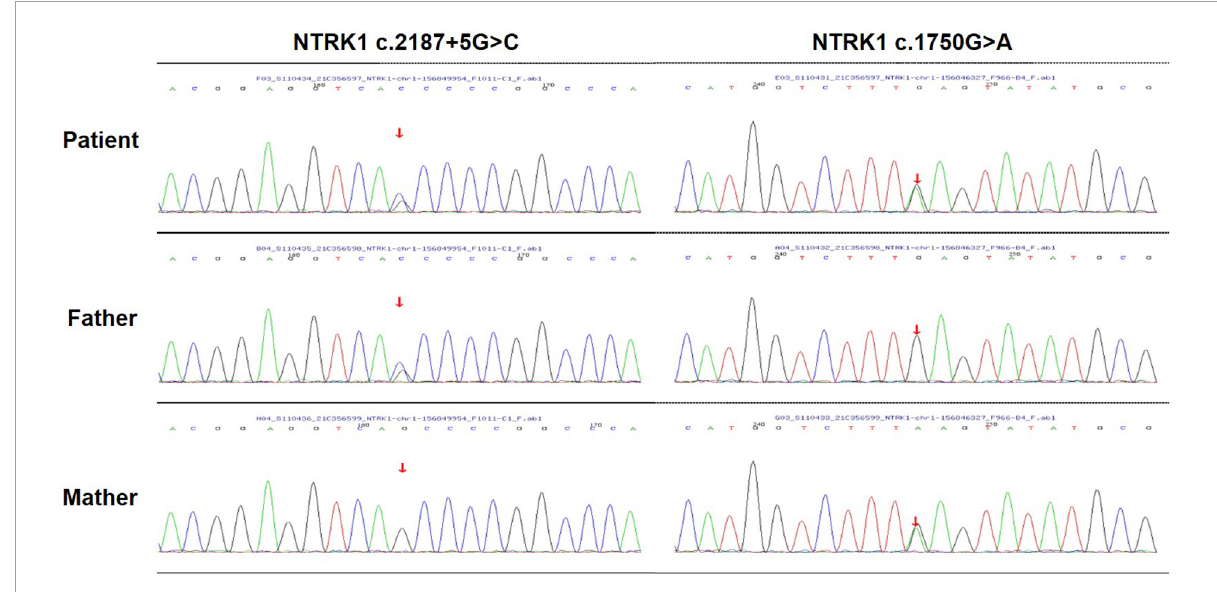
FIGURE3 Gene sequencing. Sequencing analysis of the patient revealed a compound-heterozygous mutation in NTRK1